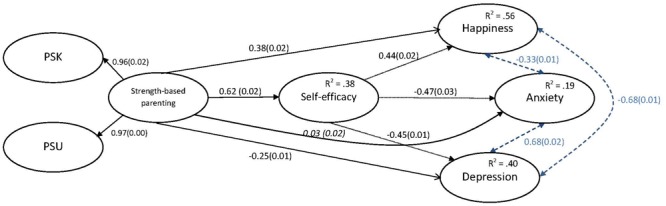
The full mediation model. Values depict standardized β weights, and values in parentheses depict the standard error of β. For convenience indirect effects are denoted by dotted lines and correlations by dashed lines. Non-significant (p > 0.05) pathways are denoted in italics. Indicators of the latent factors are not displayed for brevity. PSK, parental strength knowledge; PSU, parental strength use.